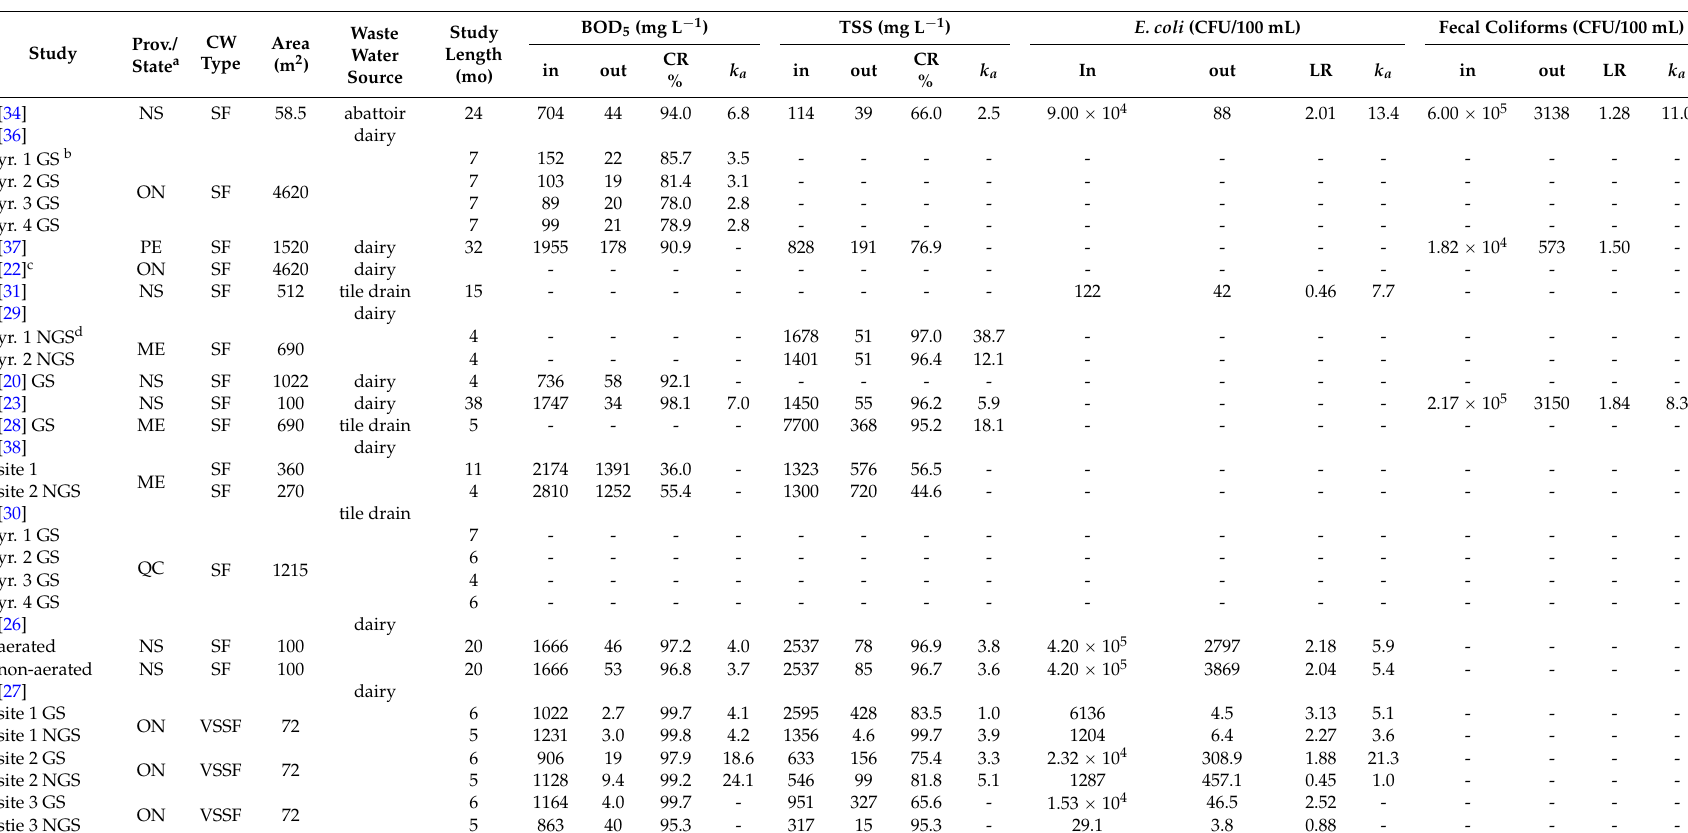
Table 1. Mean influent and effluent concentrations, concentration reductions (CR, %), and areal adjusted rate constants ( k a , y ´ 1 ) for five-day biochemical oxygen demand (BOD 5 ) and total suspended solids (TSS). Mean log reductions (LR) for E. coli , and fecal coliforms.